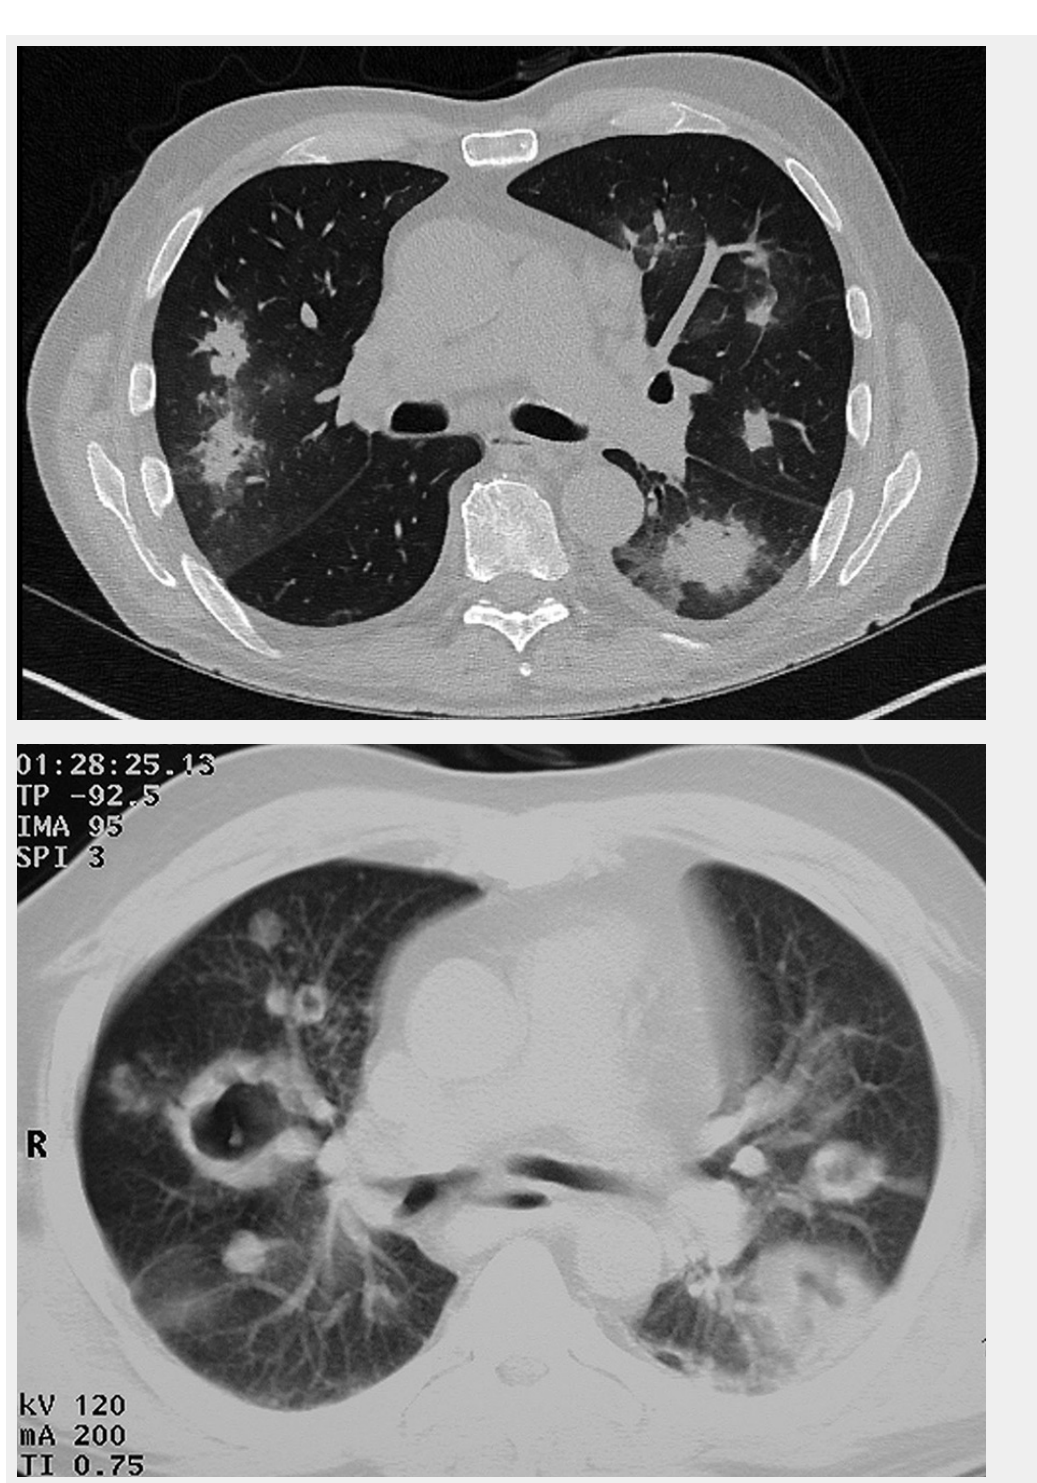
Figure 1 Computed tomography images of invasive pulmonary aspergillosis. a) Neutropenic patient, early stages: sharply demarcated nodes and dense lesions surrounded by a ground-glass halo. b) Rheumatology patient on corticosteroid treatment, early stages: centrally cavitating dense